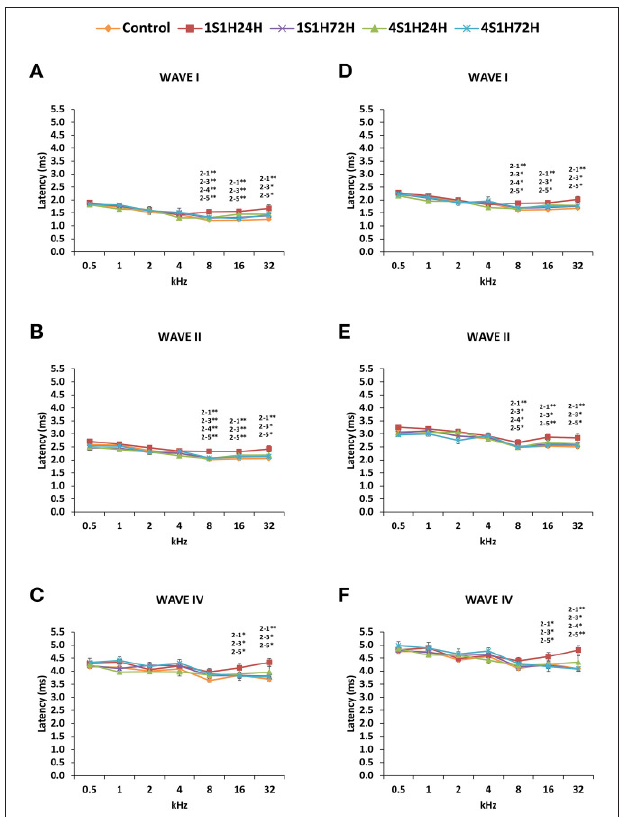
FIGURE 4 | Line graphs illustrating the latencies of the positive and negative peaks (ms) of waves I, II, and IV plotted as a function of the frequencies in control and experimental conditions. In 1S1H24H rats, there were significantly longer positive and negative peak latencies at the middle and high frequencies (A–F) . These values returned to normal at the fourth session of noise exposure (A–F) . As indicated in the Methods Section, 0.5ms of acoustic transit time between the speaker’s diaphragm and the rat’s tympanic membrane was included in the latencies. Stimulus intensity = 80dB SPL. (1) Control; (2) 1S1H24H; (3) 1S1H72H; (4) 4S1H24H; (5) 4S1H72H. * p < 0.05; ** p < 0.01.